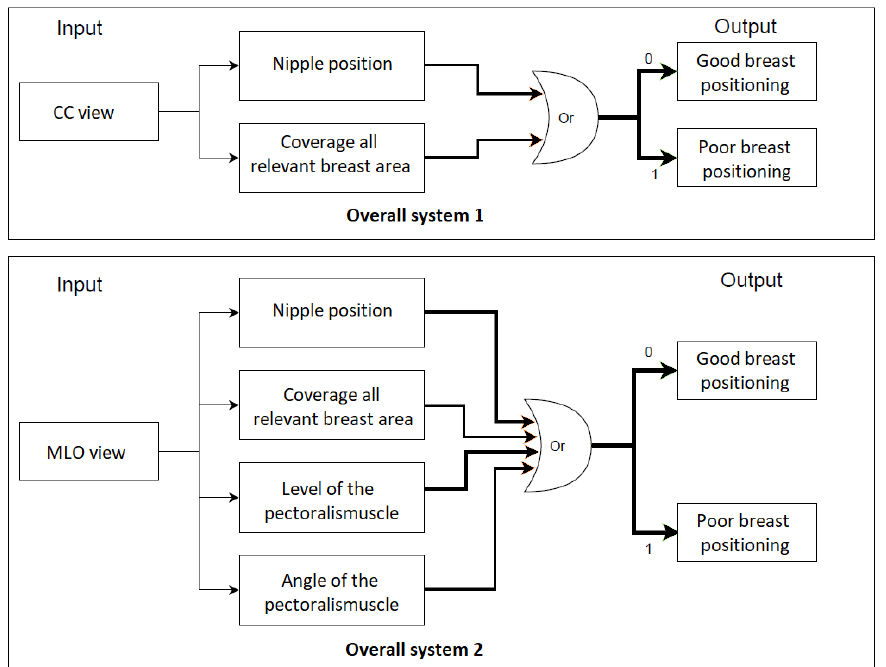
Figure 34. The overall process flow for the assessment of breast positioning quality in screening mammography. Overall system 1: Assessment of CC views, overall system 2: Assessment of MLO views. 0 refers to fulfilled quality criterion and 1 refers to non-fulfilled quality criterion.